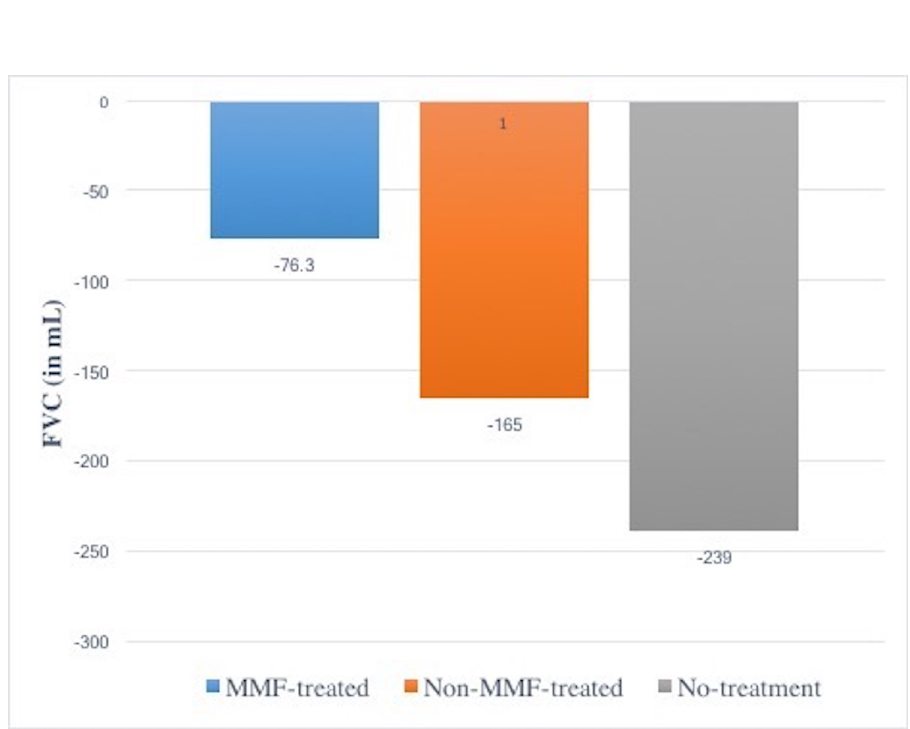
Fig 2. Change in FVC after 12 months between treatment groups. p-value = NS.